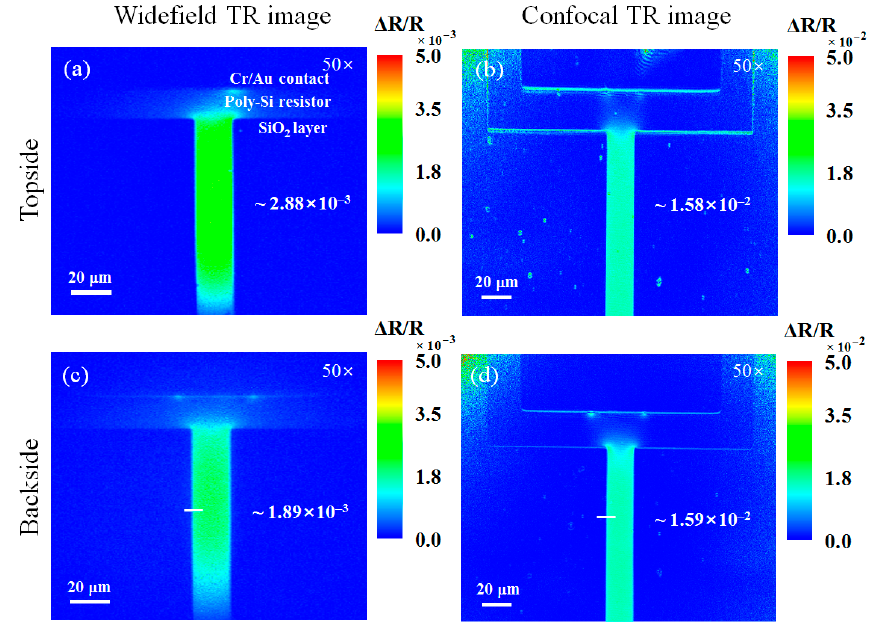
Figure 5. Topside and backside Δ R/R images of the poly-Si micro resistor that were obtained using ( a , c ) the widefield TRM and ( b , d ) the confocal TRM with a 50× objective lens (NA 0.42). The numbers in ( a – d ) indicate the Δ R/R values of the micro resistor. The solid lines in ( c , d ) indicate the locations of the profile shown in Figure 6.